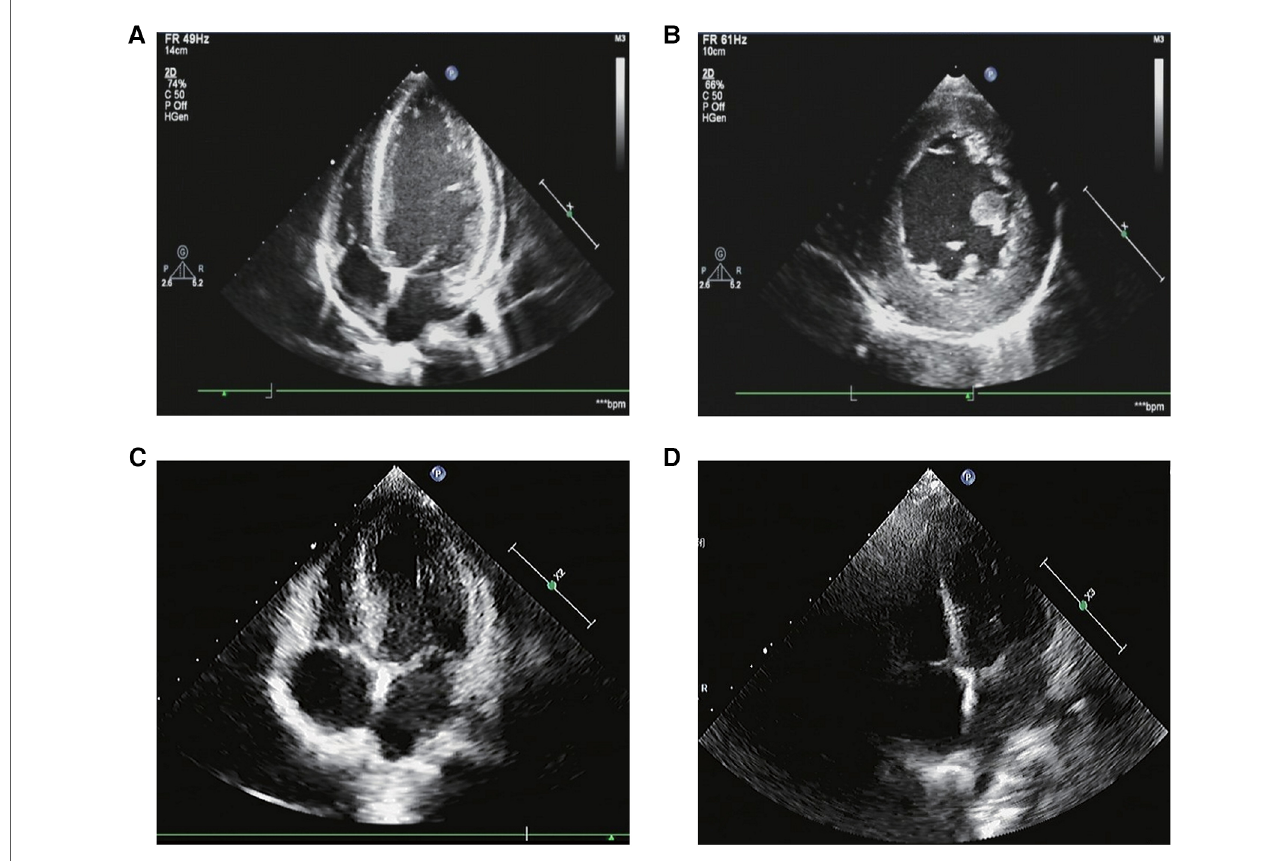
FIGURE 2 The transthoracic echocardiography. ( A,B ) The transthoracic echocardiography before the tumor resection. (1) The left atrium and ventricle were both enlarged. The ventricular septum and left ventricular free wall were generally thickened. The thicker left ventricular free wall was situated in the middle of the lateral wall, measuring about 14 mm in thickness, while the thicker ventricular septum was situated in the basal segment of the anterior septum, measuring about 12 mm in thickness. The estimated ejection fraction (EF) was about 40%. (2) Both of the bilateral coronary arteries ’ internal diameters were increased, with the left main coronary artery ’ s diameter measuring 4.1 mm and the right main coronary artery ’ s diameter measuring 3.0 mm. (3) A fl uid dark area was observed in the pericardial cavity, 8 mm in the right ventricular sidewall and 4 mm in the apex. ( C ) The transthoracic echocardiography 3 months after the tumor resection. The left ventricle was mildly enlarged. The left ventricular wall was slightly thickened. The thicker left ventricular free wall was situated in the middle of the lateral wall, measuring about 9.5 mm in thickness, while the thicker ventricular septum was situated in the basal segment of the anterior septum, measuring about 10.6 mm in thickness. The systolic function of the left ventricle was normal. ( D ) The transthoracic echocardiography 7 months after the tumor resection. The measured values of the internal diameters of each atrioventricular cavity were normal. Each chamber wall ’ s thickness and movement were both typical. The systolic function of the left ventricle was